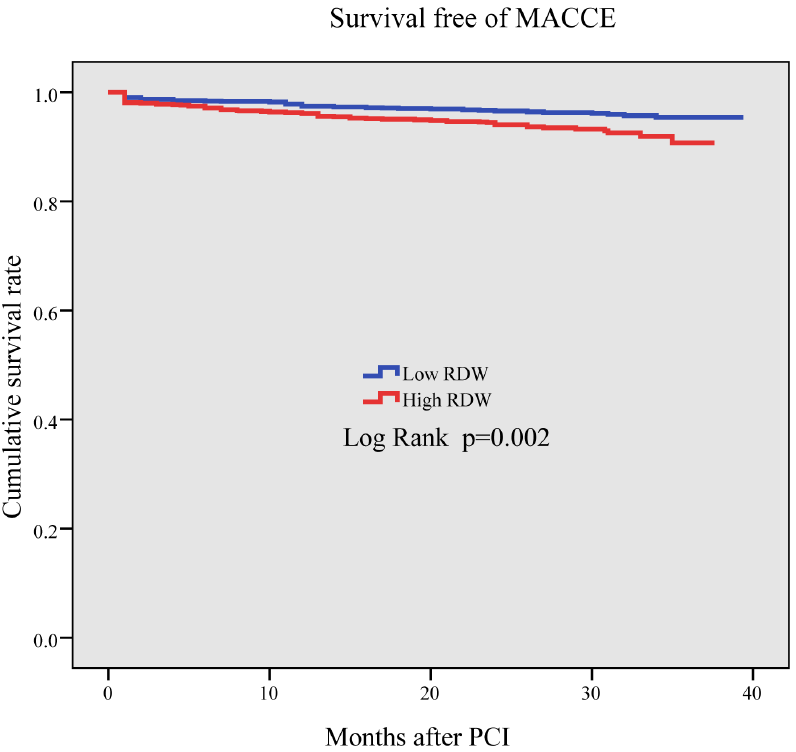
Figure 2. The Kaplan–Meier curve of MACCE rate. It is significantly higher in quartiles 3 and 4 than in quartiles 1 and 2 (p=0.002).